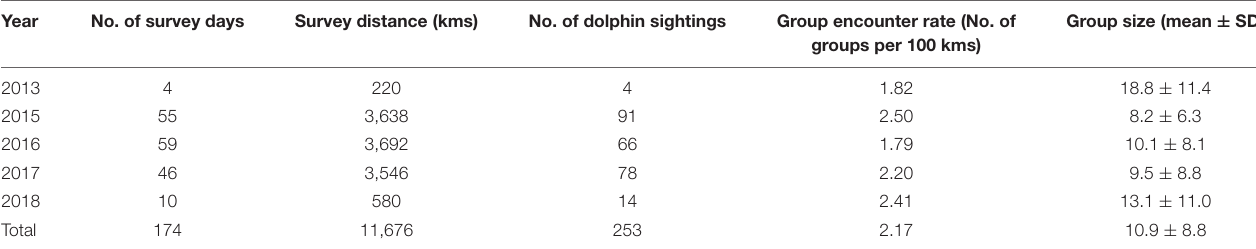
TABLE 2 | Annual survey effort, sighting information, and group size of Indo-Pacific humpback dolphins in the eastern waters of Zhanjiang, China, in 2013, and 2015–2018. Year No. of survey